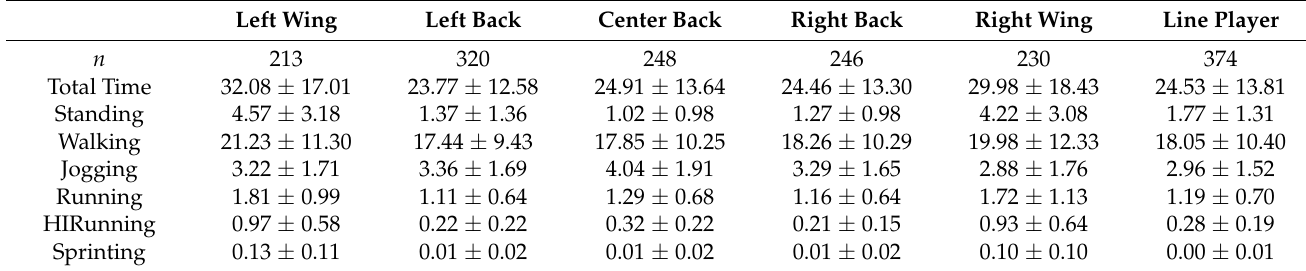
Table 2. Total time (minutes) played in different locomotion categories by playing positions. Left Wing Left Back Center Back Right Back Right Wing Line